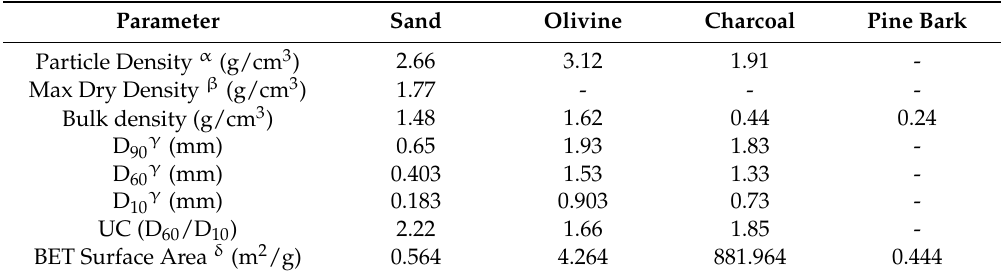
Table 1. Material properties of the sand and adsorbents used in the study. UC stands for uniformity coefficient.